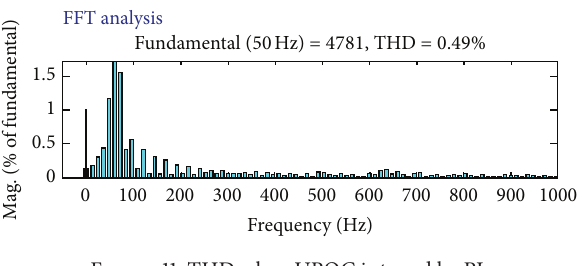
Figure 11: THD when UPQC is tuned by PI.